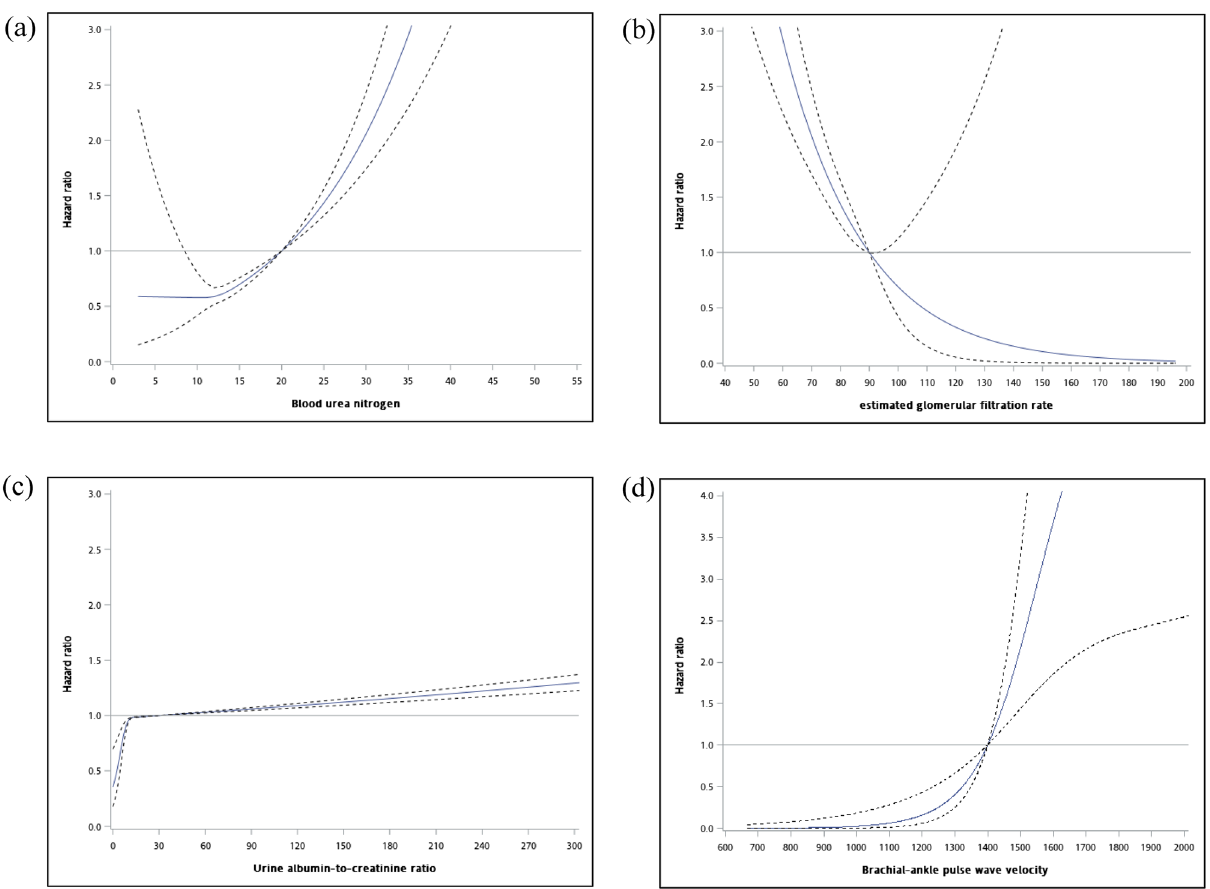
Figure 2. Restricted cubic spline model displaying the hazard ratios for expanded cardiovascular disease mortality by ( a ) BUN, ( b ) eGFR, ( c ) urine ACR, and ( d )